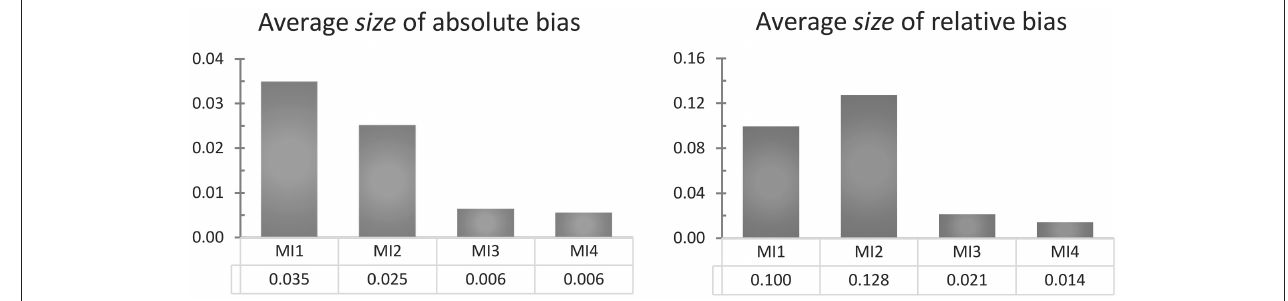
FIGURE 4 | A comparison of the average size of the absolute and relative bias (ignoring its sign) of each model implementation over all true φ (from 0.1 to 0.9), in the univariate simulation with one very long time series (of 1,000 days) and no minimum interval